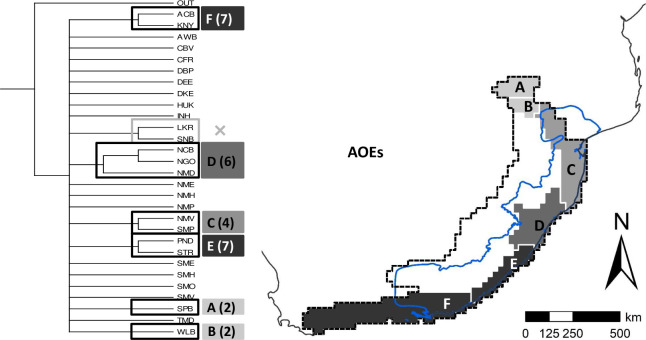
Delineation of areas of endemism (AOEs) for land snails in south-eastern Africa based on the strict consensus tree of parsimony analysis of endemicity (PAE).Four of the five clades in the area cladogram harbour more than two sympatric endemic species, and hence identified as AOEs, together with two OGUs each with two narrow endemics with congruent ranges. All six AOEs are shaded in the map on a grey scale according to the number of endemic species, given below for each in brackets (darker shades denotes high endemism; see Table 3 for lists of endemic species): A—Soutpansberg (2), B—Wolkberg (2), C—Extended Maputaland (4), D—Natal (6), E—Extended Pondoland (7), and F—Albany-Knysna. The MPA hotspot boundary is reprinted from Hoffman et al. [26] (public domain).